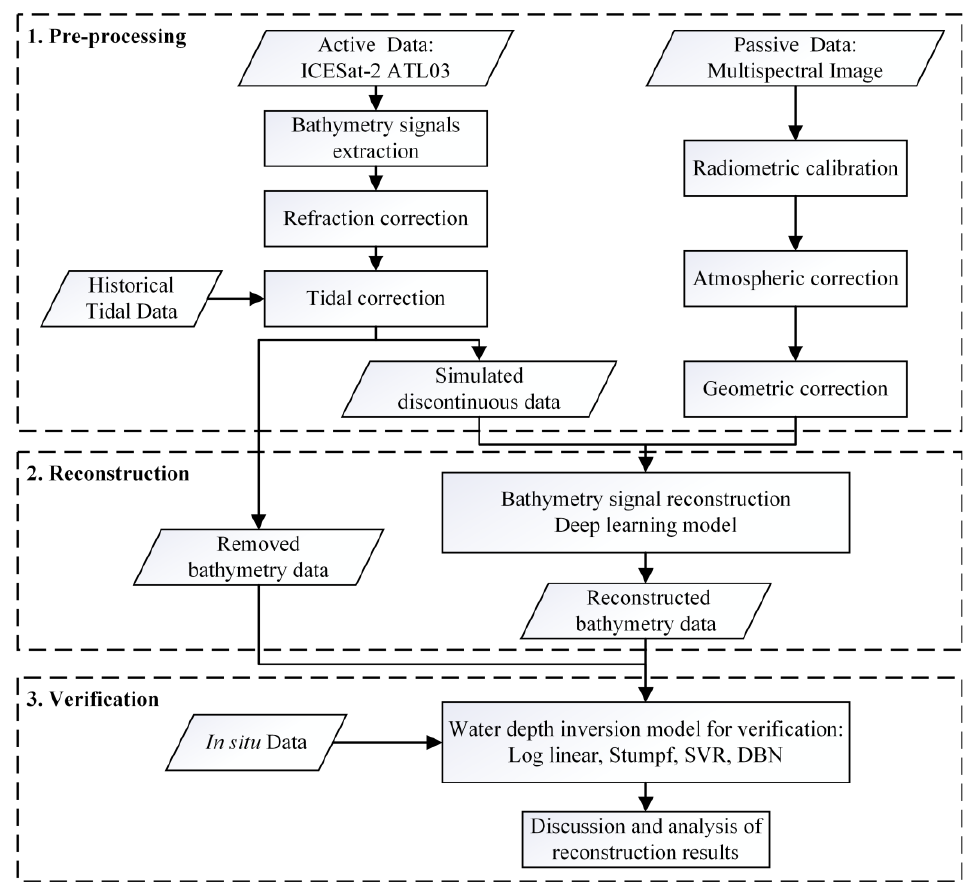
Figure 5. The flowchart of the bathymetric signal reconstruction framework. It consists of three core parts: data pre-processing, ICESat-2 data reconstruction, and verification of the reconstruction effect.